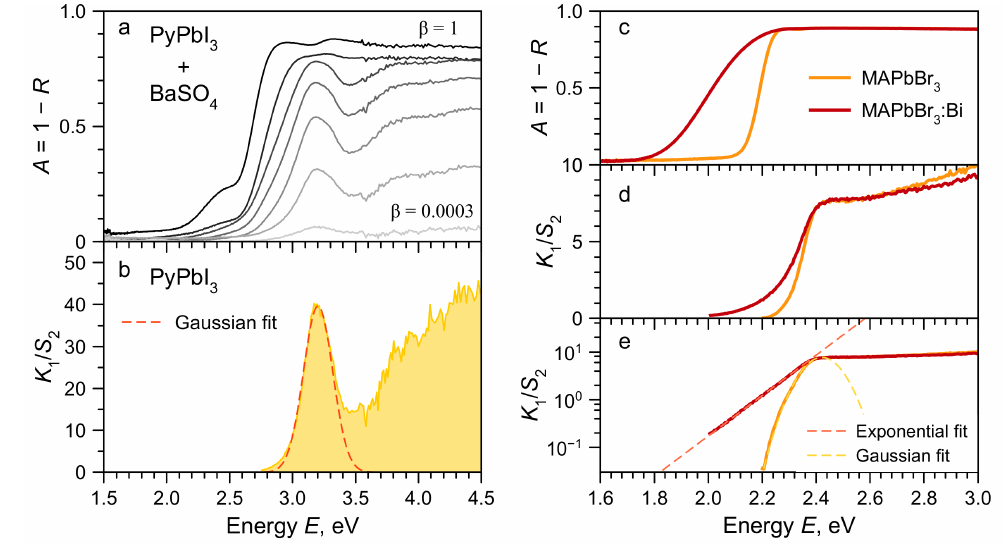
Figure 2. ( a ) DRS spectra of powders mixtures of PyPbI 3 and BaSO 4 for different mass fractions β . ( b ) Relative absorption K 1 coefficients of PyPbI 3 extracted from DRS data fitting. Dashed line— S 2 Gaussian fit of the excitonic resonance. ( c ) DRS spectra and relative absorption K 1 coefficients in S 2 linear ( d ) and log ( e ) scales for undiluted MAPbBr 3 (orange curves) and MAPbBr 3 :Bi (red curves) powders. Dashed curves in ( e ) are fits by Gaussian (orange) and exponent (red)